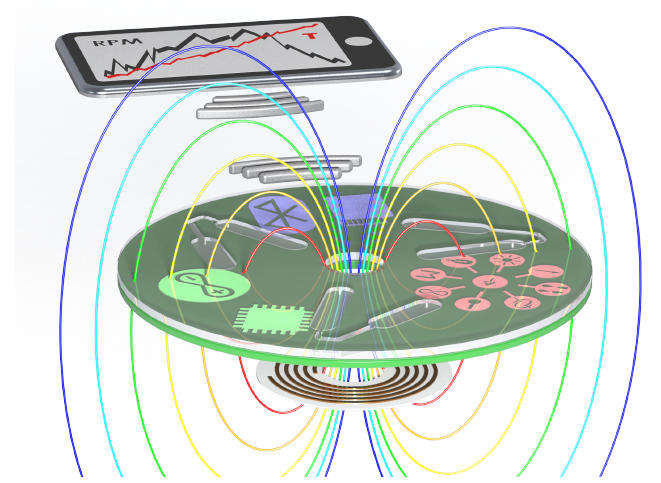
Figure 11. Concept design of smart power mechanisms for centrifugal microfluidics to allow for advanced functionality and connectivity on CD-based